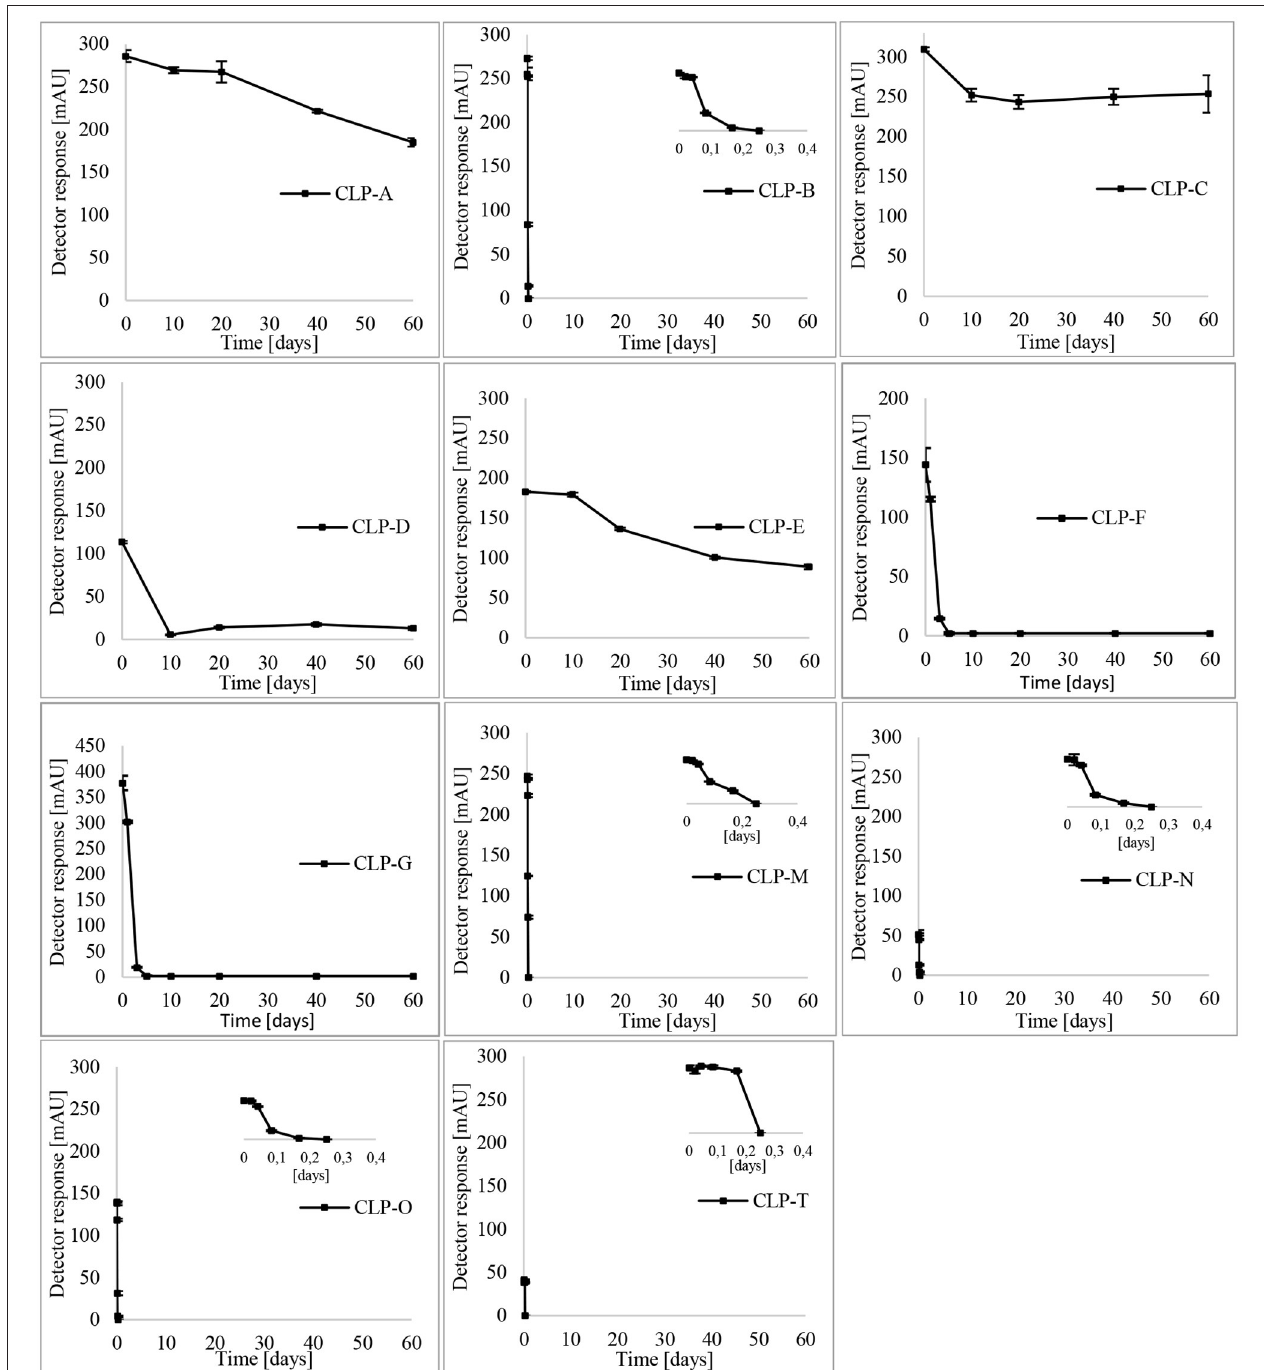
FIGURE 5 | Degradation of 11 CLPs at 90 ◦ C from a mild-aged mixture of “PB” and fresh “FA” oil